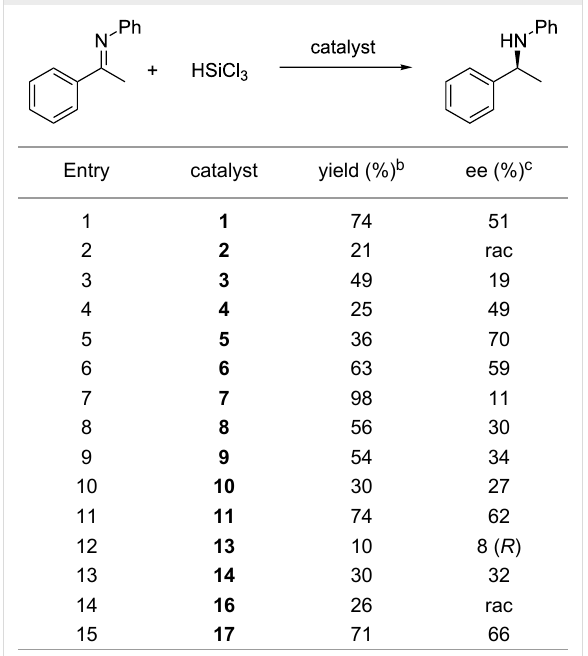
Table 2: Enantioselective reduction of the N -phenyl imine of acetophe- none.